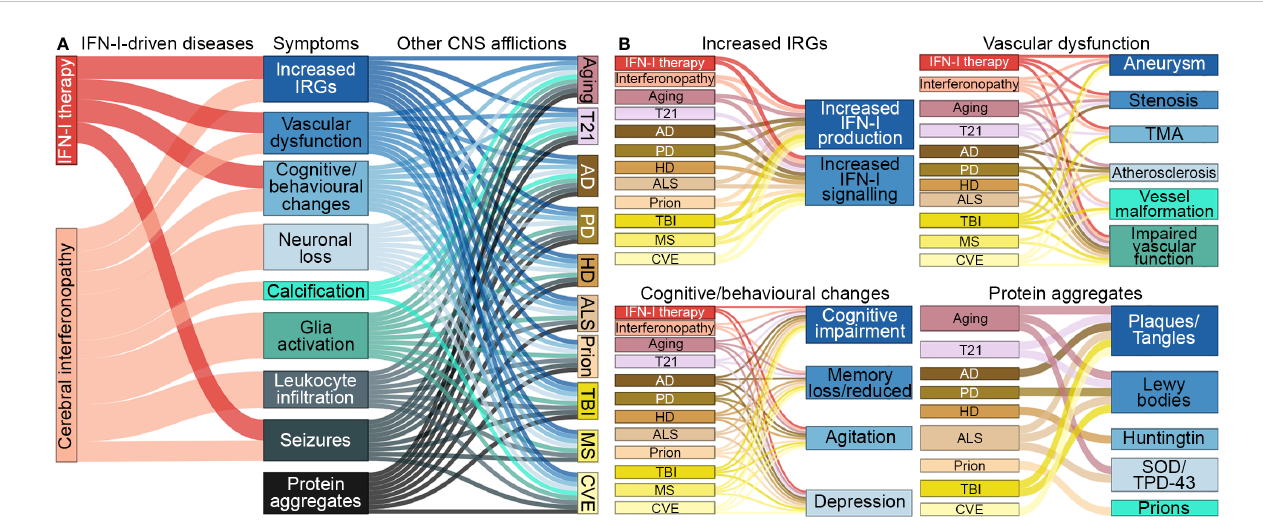
FIGURE 2 Symptomatic links between IFN-I-driven diseases and CNS af fl ictions. (A) Symptoms that arise in diseases driven by IFN-Is overlap with symptoms that occur in aging, trisomy 21 and several neurodegenerative diseases, trauma, autoimmune diseases and chronic viral infections, CNS af fl ictions found to have increased IFN-I signaling. (B) Further breakdown of symptoms linked to each of the CNS af fl ictions. Note, protein aggregates can lead to increased IFN-Is and expression of IRGs. CNS-centric symptoms were compared and linked if there was prevalence in several human cases. Size of nodes and links are arbitrary. T21, Trisomy 21; AD, Alzheimer ’ s disease; PD, Parkinson ’ s disease; HD, Huntington ’ s disease; ALS, amyotrophic lateral sclerosis; TBI, traumatic brain injury; MS, multiple sclerosis; CVE, chronic viral encephalopathy; TMA, thrombotic microangiopathy; SOD, superoxide dismutase; TPD- 43, transactive response DNA binding protein 43